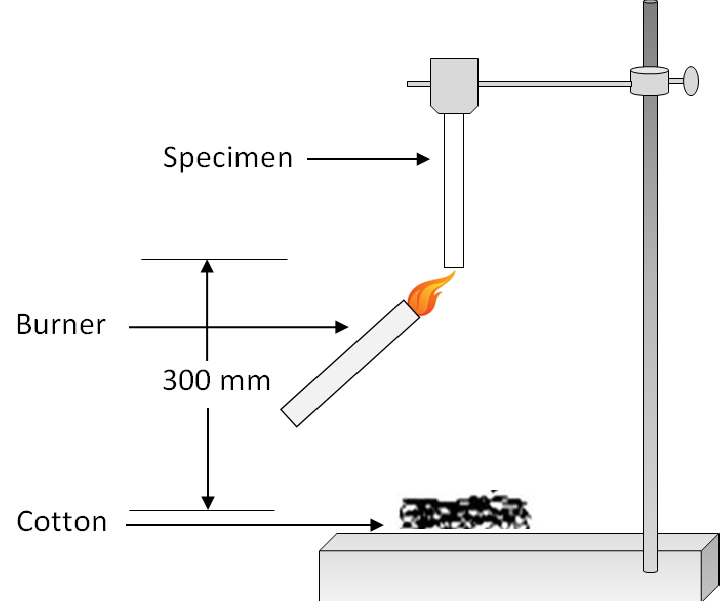
Figure 6. Schematic diagram of UL-94 vertical burning test.